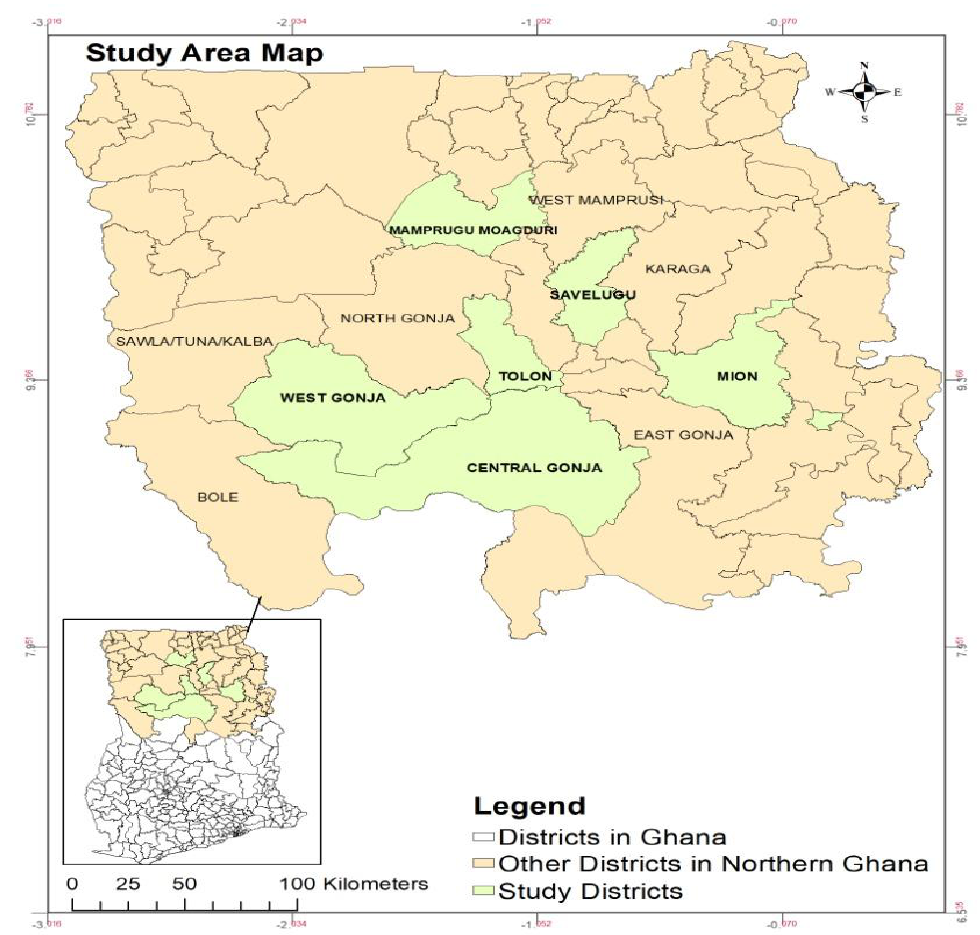
Figure 1. A map of northern Ghana showing the study districts.